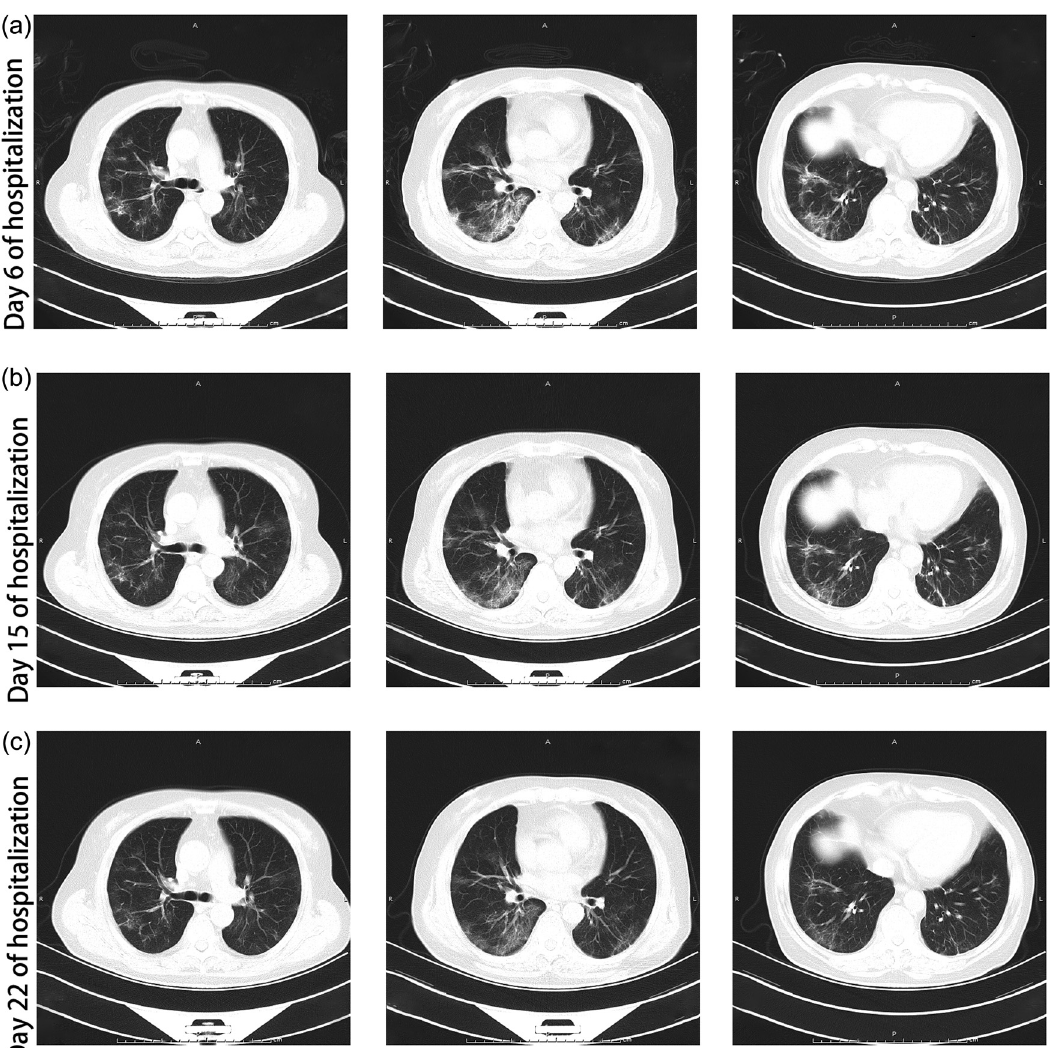
Figure 2: Thoracic CT images. ( a ) Thoracic CT of day 6 of hospitalization showed bilateral ground - glass, patchy and cord - like shadows. ( b ) Thoracic CT of day 15 of hospitalization showed that pulmonary in fi ltration was partly absorbed. ( c ) Thoracic CT of day 22 of hospita - lization showed that pulmonary in fi ltration was absorbed